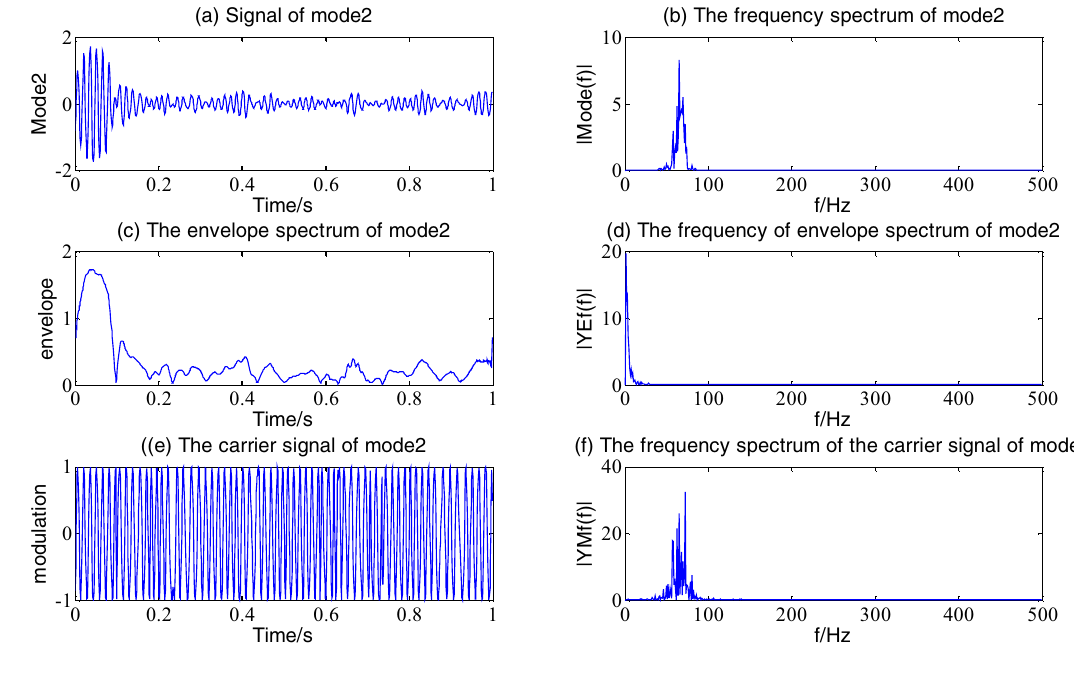
Figure 8. The envelope demodulation distribution diagram of mode2.